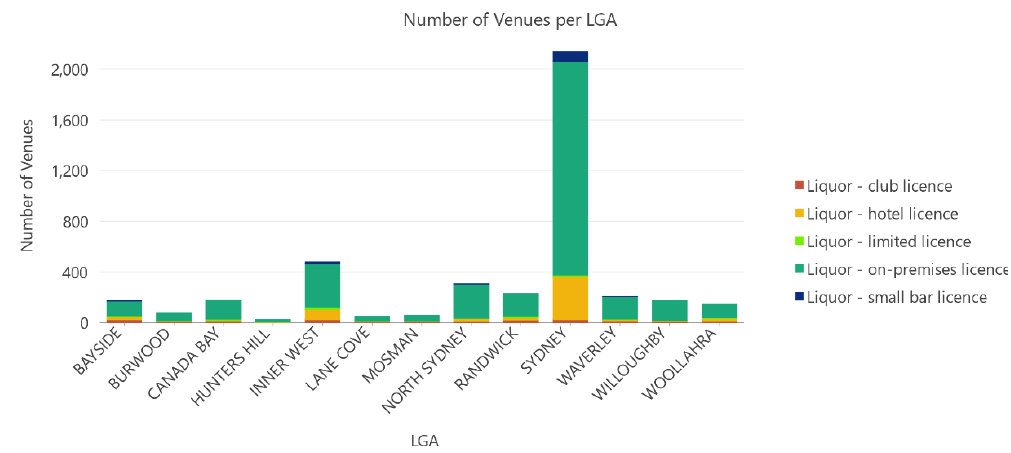
Figure 5. Number of venues per LGA. Table 1. Licensed venues per local government area (LGA).